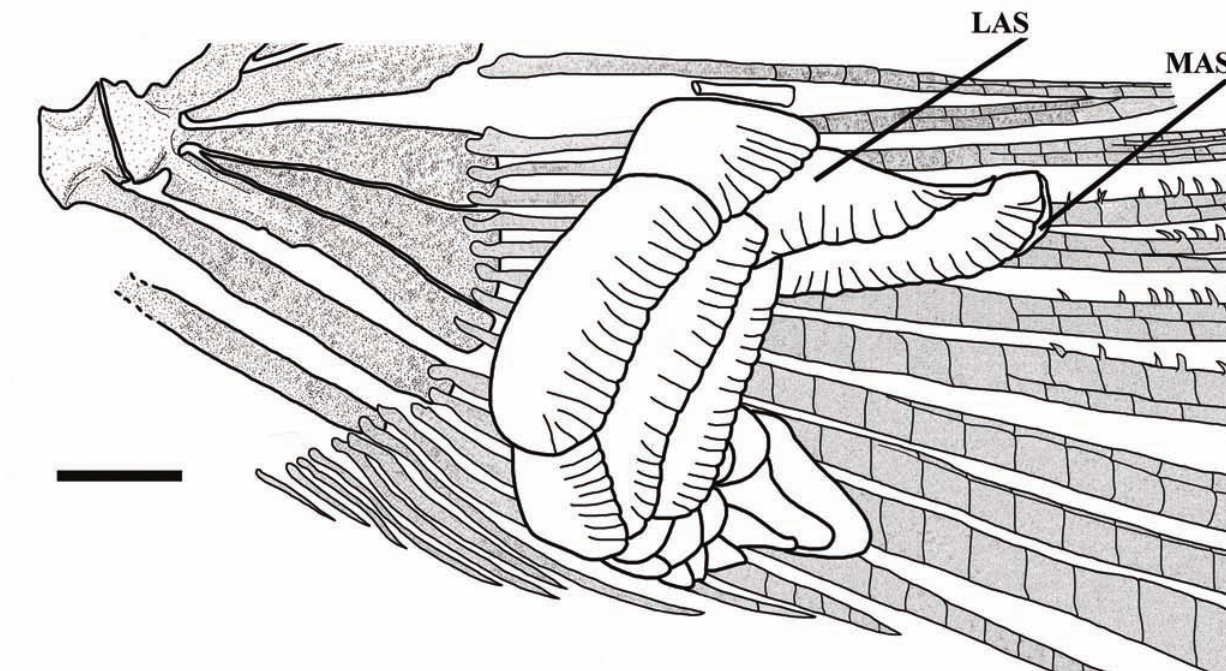
Fig. 3. Chrysobrycon yoliae , paratype male, CI-FML 5882, 44.8 mm SL. Lateral view of the ventral lobe of caudal fin, left side. Note the scales forming the pouch in this lobe. MAS: Medial accessory scale, LAS: Lateral accessory scale. Scale bar = 1 mm.